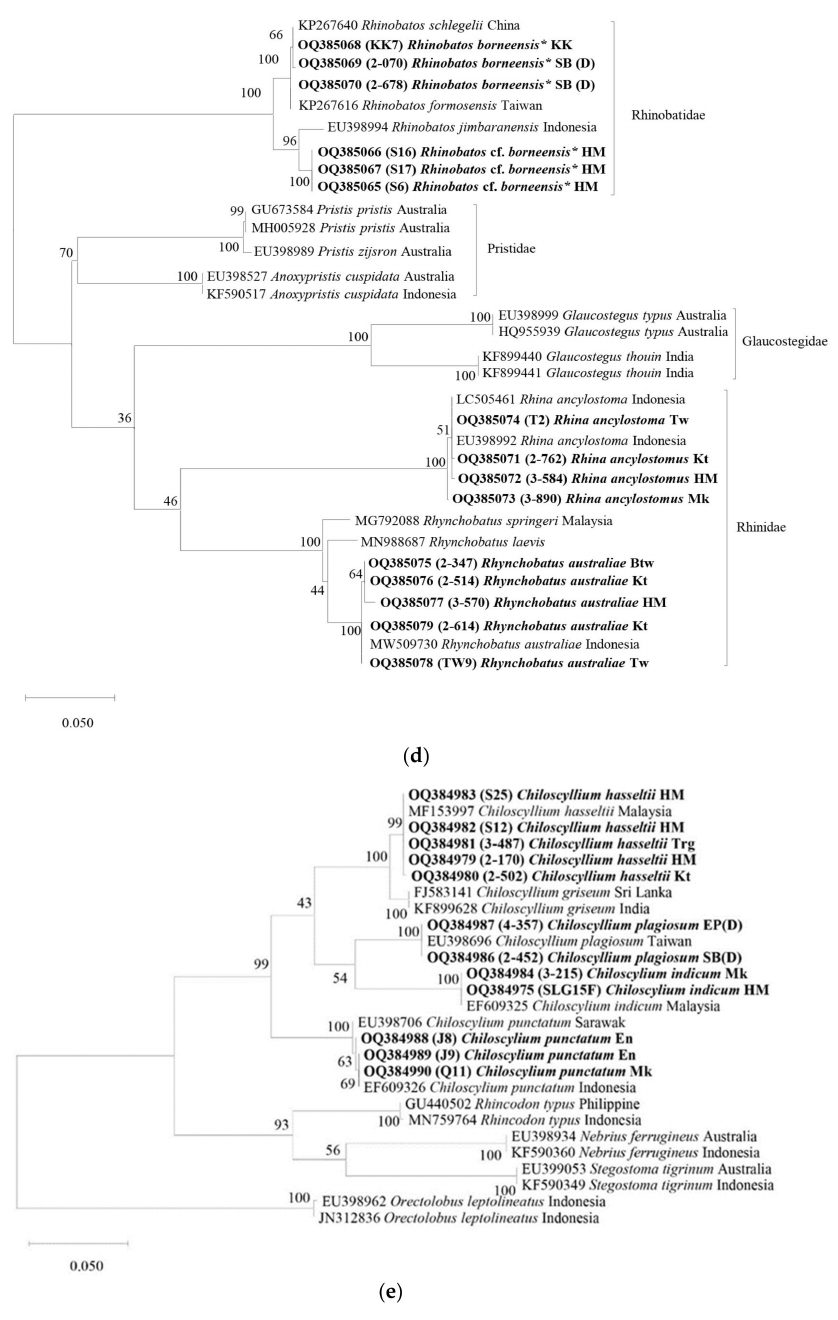
Figure 2. Maximum likelihood (ML) mid-point rooting tree based on Kimura-2-Parameter (K2P) distances of COI gene of ( a ) sharks and batoids. ( b ) Myliobatiformes species. ( c ) Carcharhiniformes species. ( d ) Rhinopristiformes species. ( e ) Orectolobiformes species. The bootstrap values (ML) are shown at branches. Sequence names in bold are from the present study. * Indicate specimens of concern. See Table 1 for the abbreviation of locations for sequences from the present study The exceptions among batoids were listed as follows. Hemitrygon parvonigra (samples 2-059, 2-127, 2-448, and T8) was separated from the reference sequence of the species at 5.2% inter-clade genetic distance. The species identity of the Neotrygon kuhlii reference sequences found in Malaysian waters were updated to N. malaccensis , N. orientalis, and N. varidens, according to the assigned species names in Borsa et al. [74]. After renaming the references sequences, the Neotrygon sequences from the present study (samples S10, S11, Q12, 3-459, 3-619, 4-421, and 4-457) were found to cluster with the reference